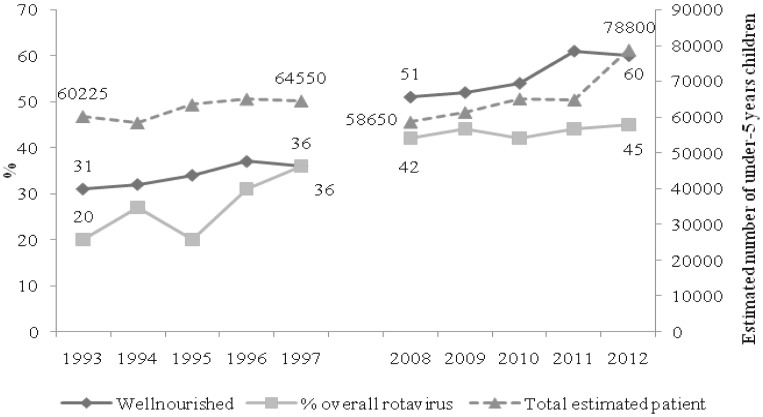
Overall and nutrition specific distribution of rotavirus diarrhea among under-5 children in two observation periods (1993–1997 and 2008–2012).